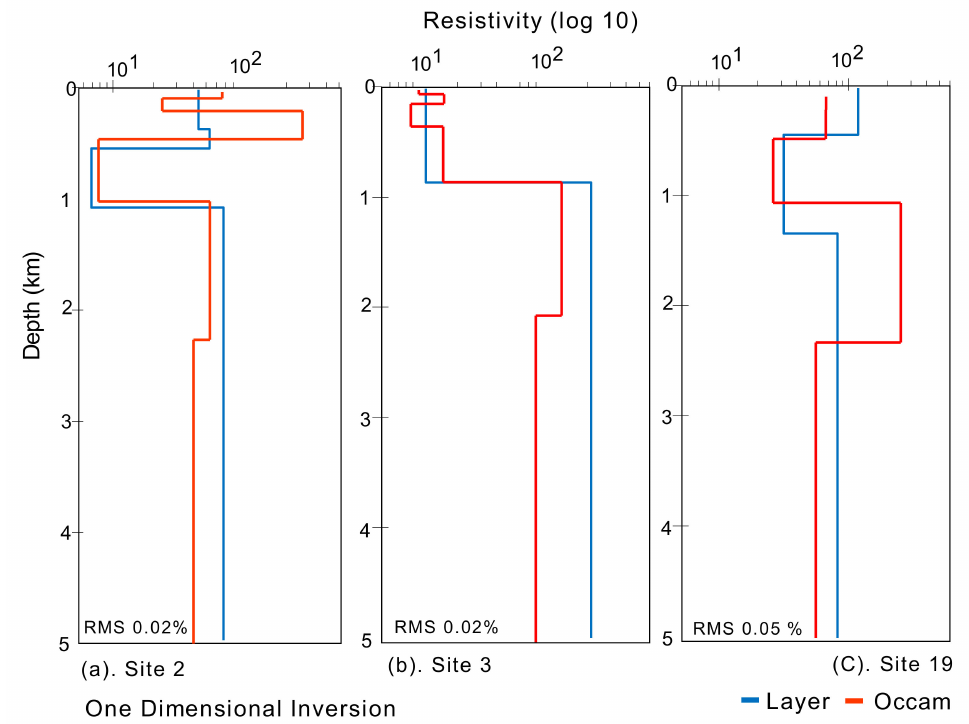
Figure 7. The inversion results were obtained via Occam calculations at various measurement stations: ( a ) site 02 and ( b ) site 03, which are located close to the Cempaga crater and the top of the volcano, respectively; ( c ) site 19, which is close to the Heutz crater. The blue line is the initial layer of the model, while the red line is the result of Occam inversion with 10